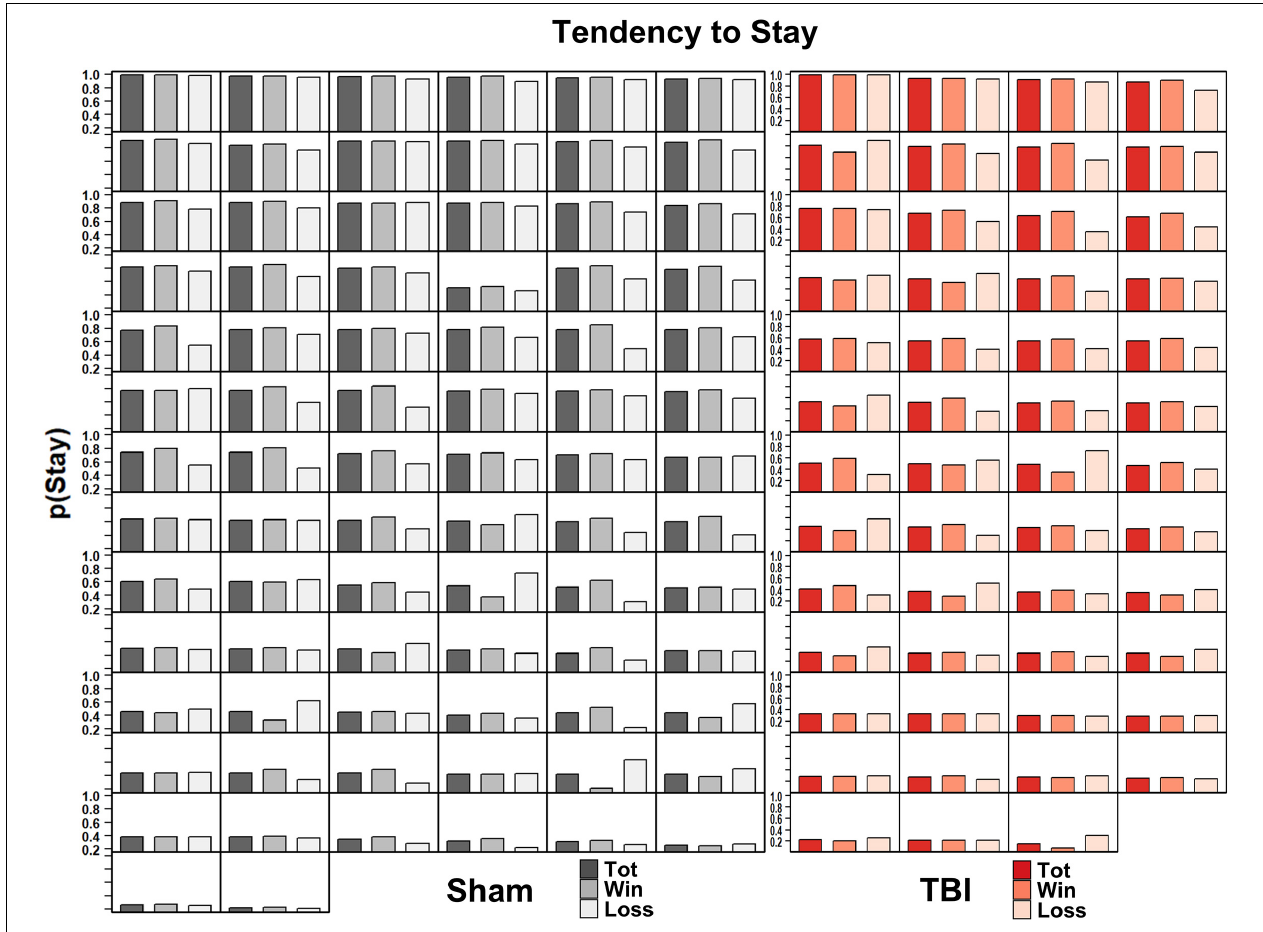
FIGURE 5 | Individual subject’s probability of staying with a choice across total trials, winning trials, and losing trials in Sham (left, black) and TBI (right, red) subjects. There was considerable variability in the tendency to stay with a choice across